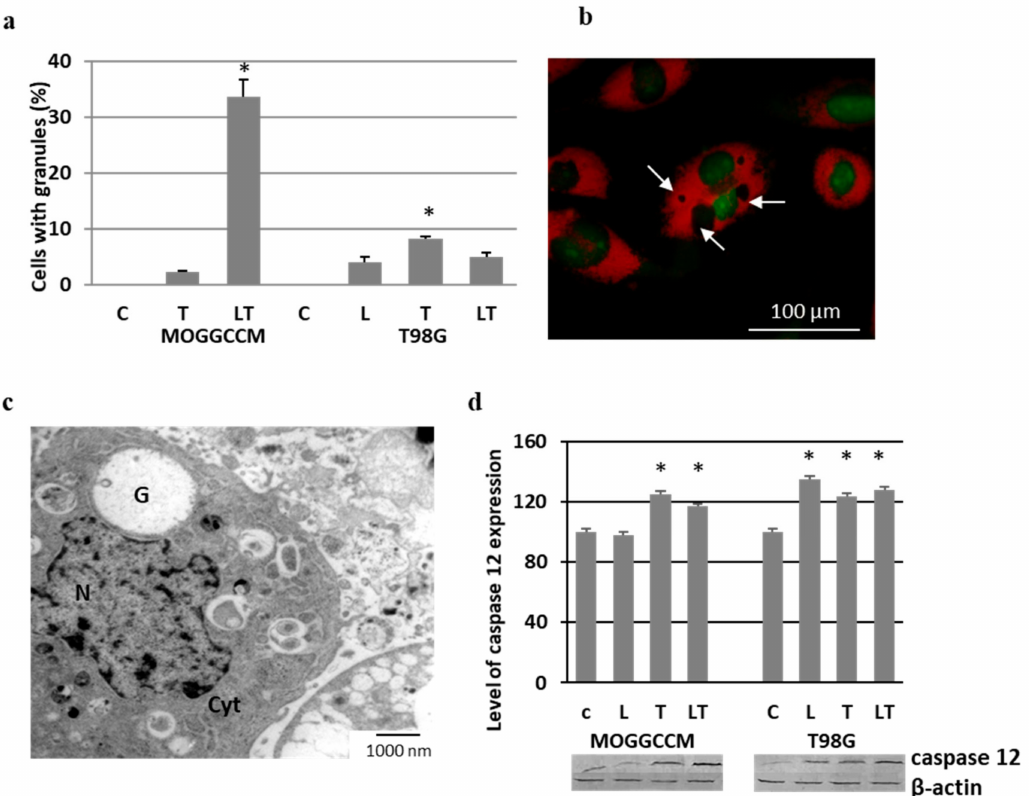
Figure 8. Granule formation in MOGGCCM and T98G cells upon LY294002 (L) and temozolomide (T) treatment. ( a ) Quantitative analysis; ( b ) picture of granules in MOGGCCM cell after LT incubation, not stained with acridine orange and indicated by arrows; ( c ) MOGGCCM electron micrograph with granule (G) after LT treatment (N—nucleus, Cyt—cytoplasm); ( d ) level of caspase 12 expression with representative blots. C—control, * p < 0.01 compared to